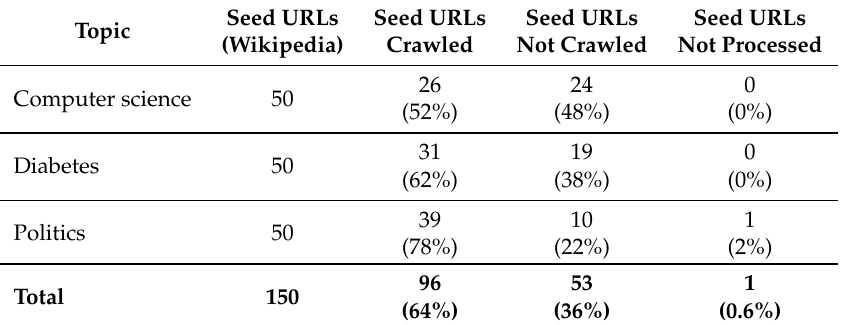
Table 5. Corpus Wikipedia pages